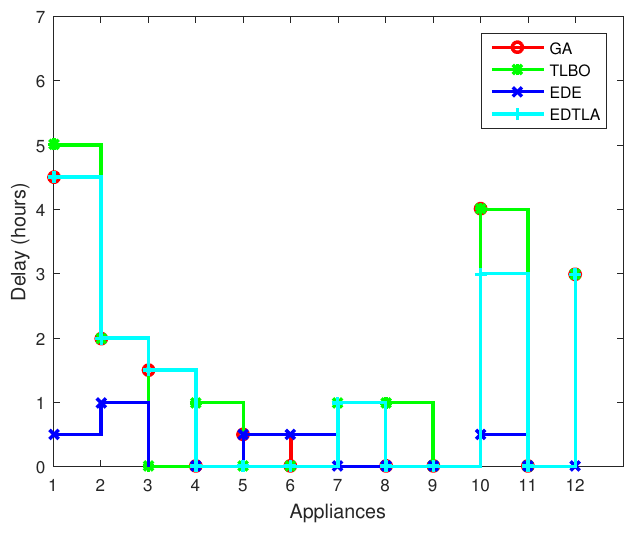
Figure 20. User discomfort.